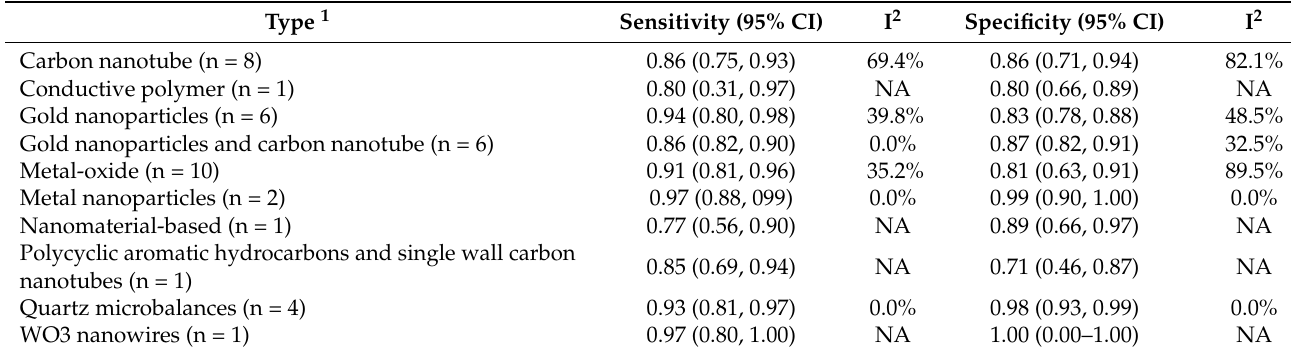
Table 2. Subgroup analysis based on the type of